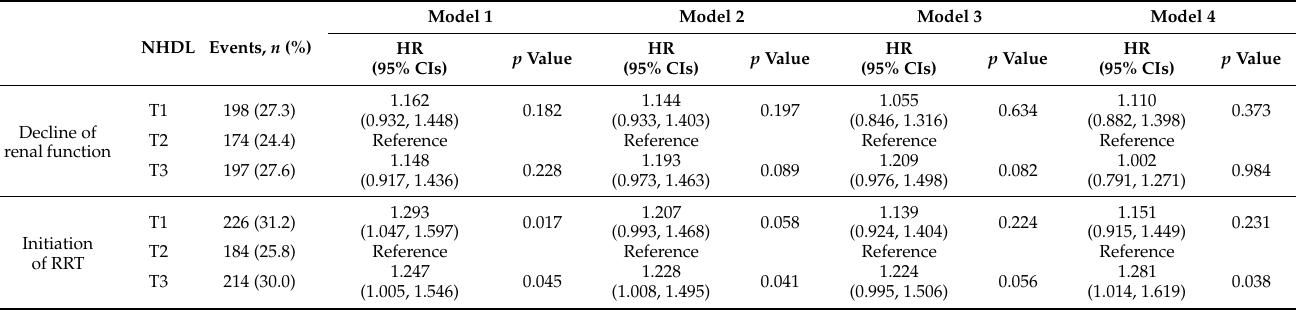
Table 3. HRs for the secondary outcomes by nHDL level.